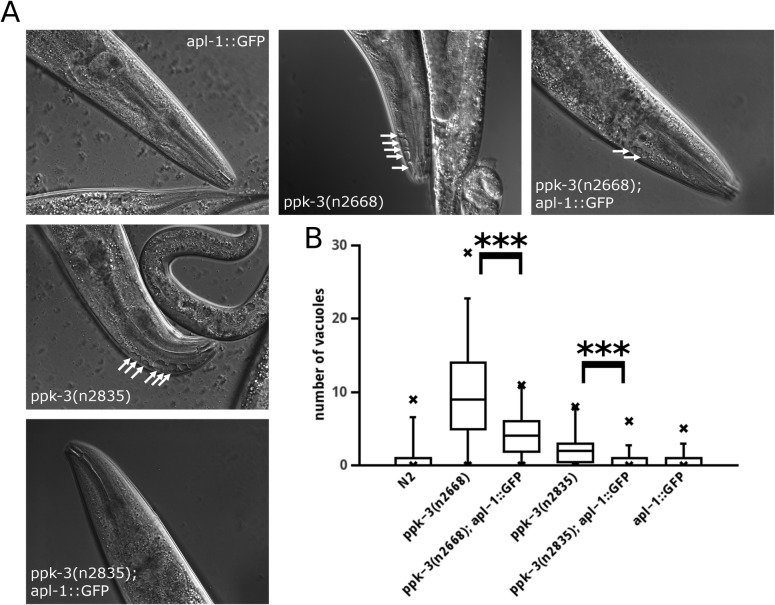
Overexpression of APL-1 reduces vacuolar pathology caused by hypomorphic PIKfyve complex mutants.(A, B) Overexpression of APL-1::GFP (established in [32]) significantly reduced the number of vacuoles in PPK-3 partial loss-of-function mutant animals (Wilcoxon rank test, p<0.01, n≥25 per strain). Note that in the case of the stronger hypomorphic ppk-3(n2668) mutant APL-1::GFP expression, while strongly ameliorating the phenotype, failed to fully rescue the vacuolar phenotype.